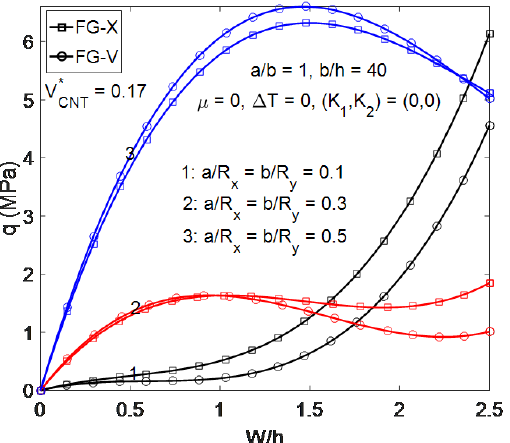
Fig. 9: Effects of curvature on the nonlinear response of FG-CNTRC spherical panels under uniform external pressure with immovable edges.